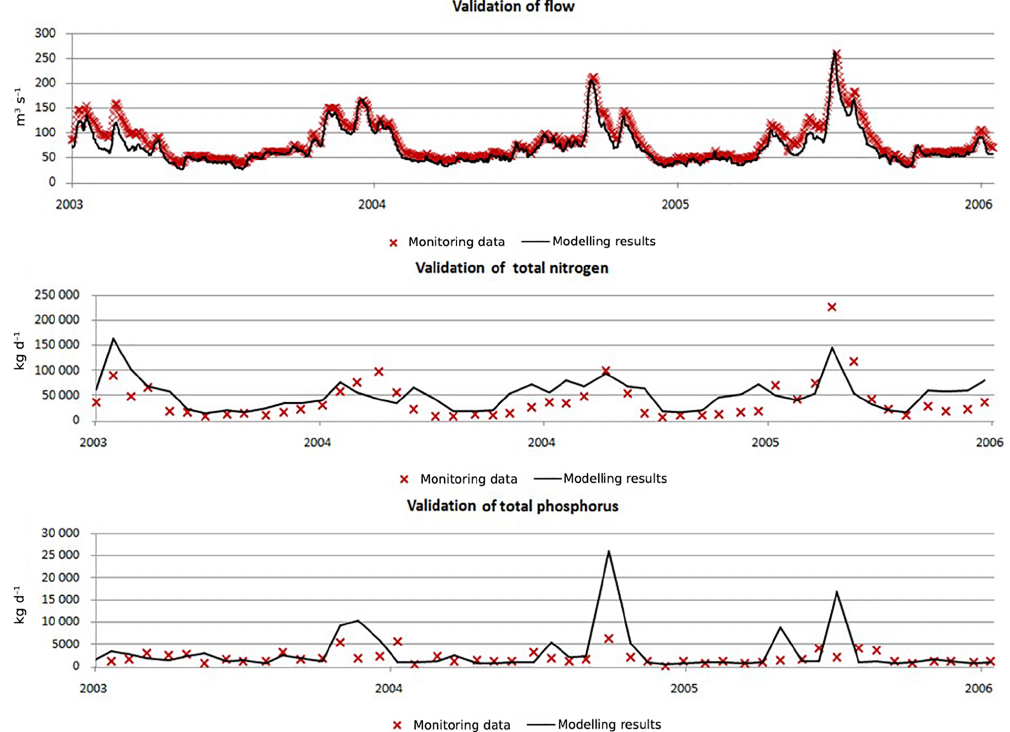
Figure 7. Matching of modelling results and monitoring results for the period of